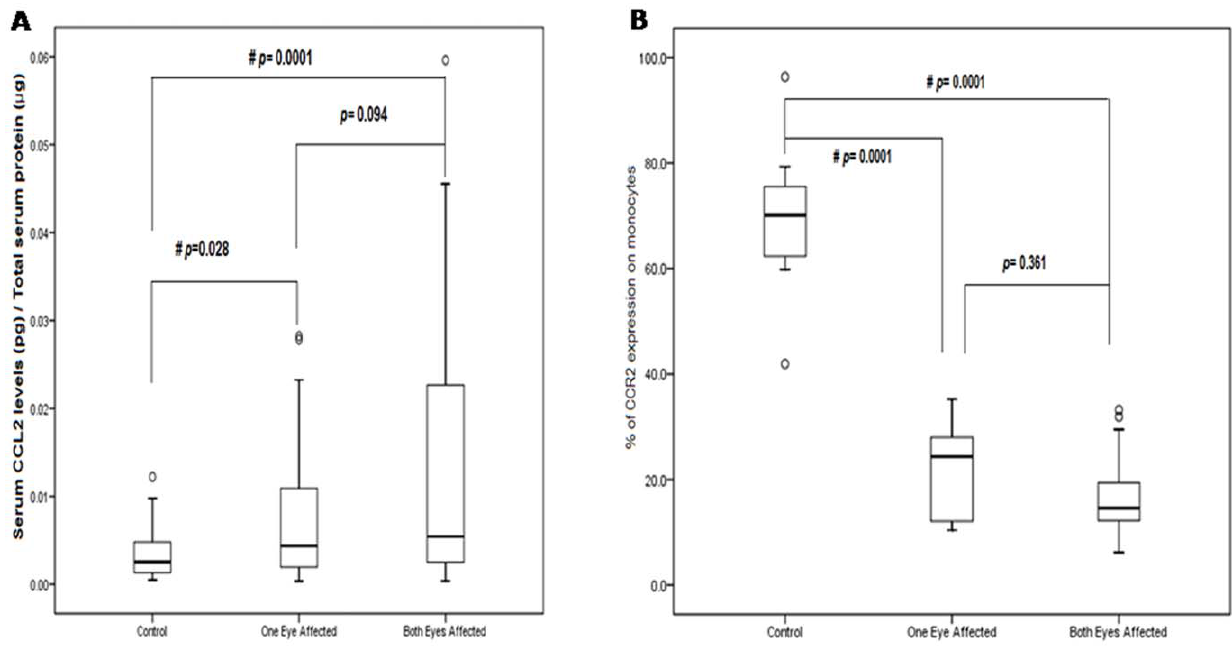
Figure 4. A) Serum levels of CCL2 in normal controls, AMD patients affected in one eye and AMD patients affected in both eyes. B) Percentage (%) of PBMCs expressing CCR2 protein in normal controls, AMD patients affected in one eye and AMD patients affected in both eyes. Boxes include values from first quartile (25th percentile) to third quartile (75th percentile). Lower and upper error bar refers to 10th and 90th percentile respectively. The thick horizontal line in the box represents median for each dataset. Outliers and extreme values are shown in circles and asterisk respectively. Levels of CCR2 were normalized to total protein. # indicates significant difference (p , 0.05) between the given conditions. Data was analyzed by Mann Whitney U Test. CCL2, Chemokine ligand 2; CCR2, Chemokine Receptor 2; pg, picogram; m g,